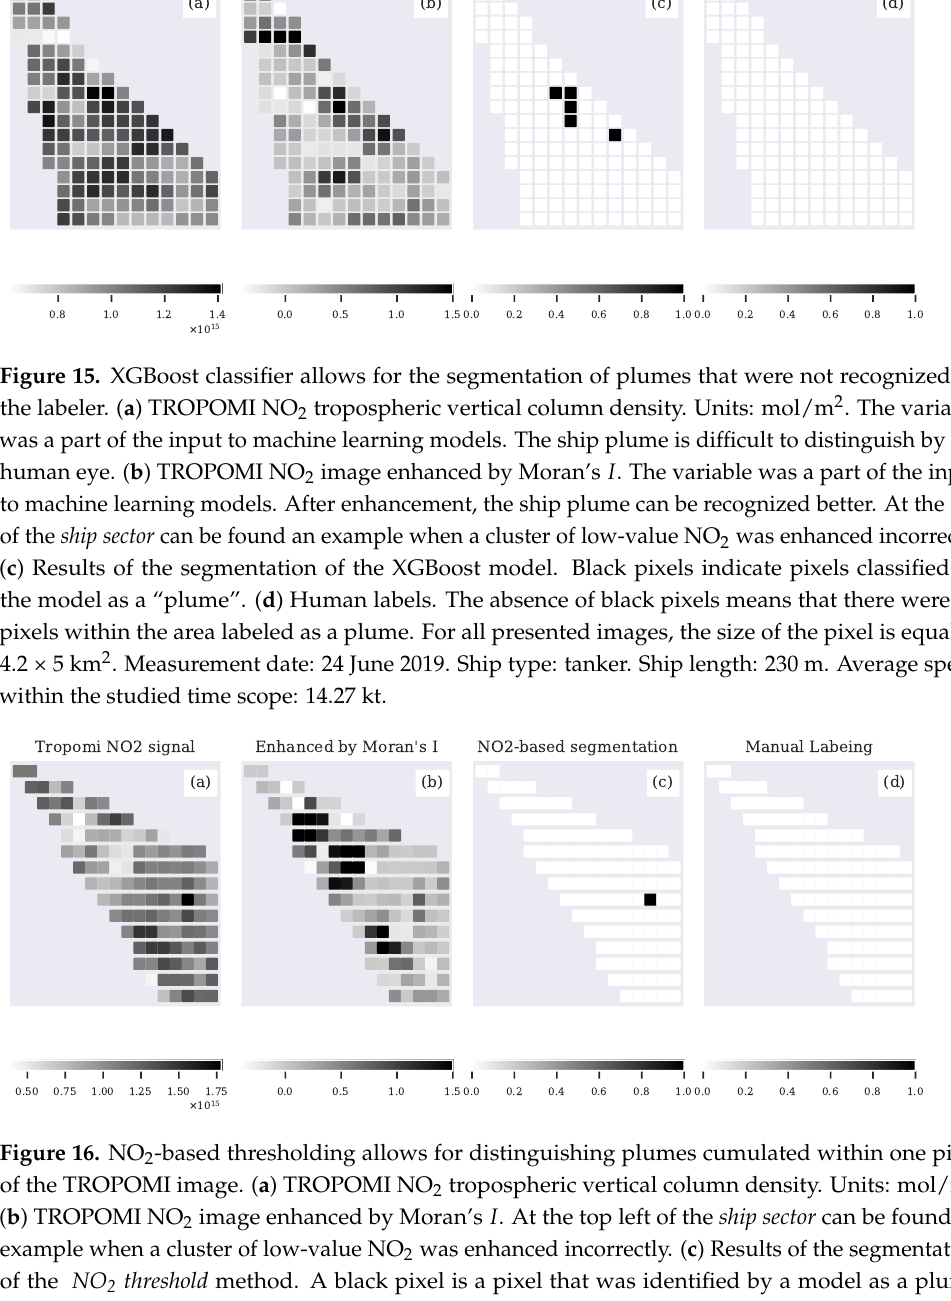
as plumes. The substantially high correlation with the emission proxy suggests that the